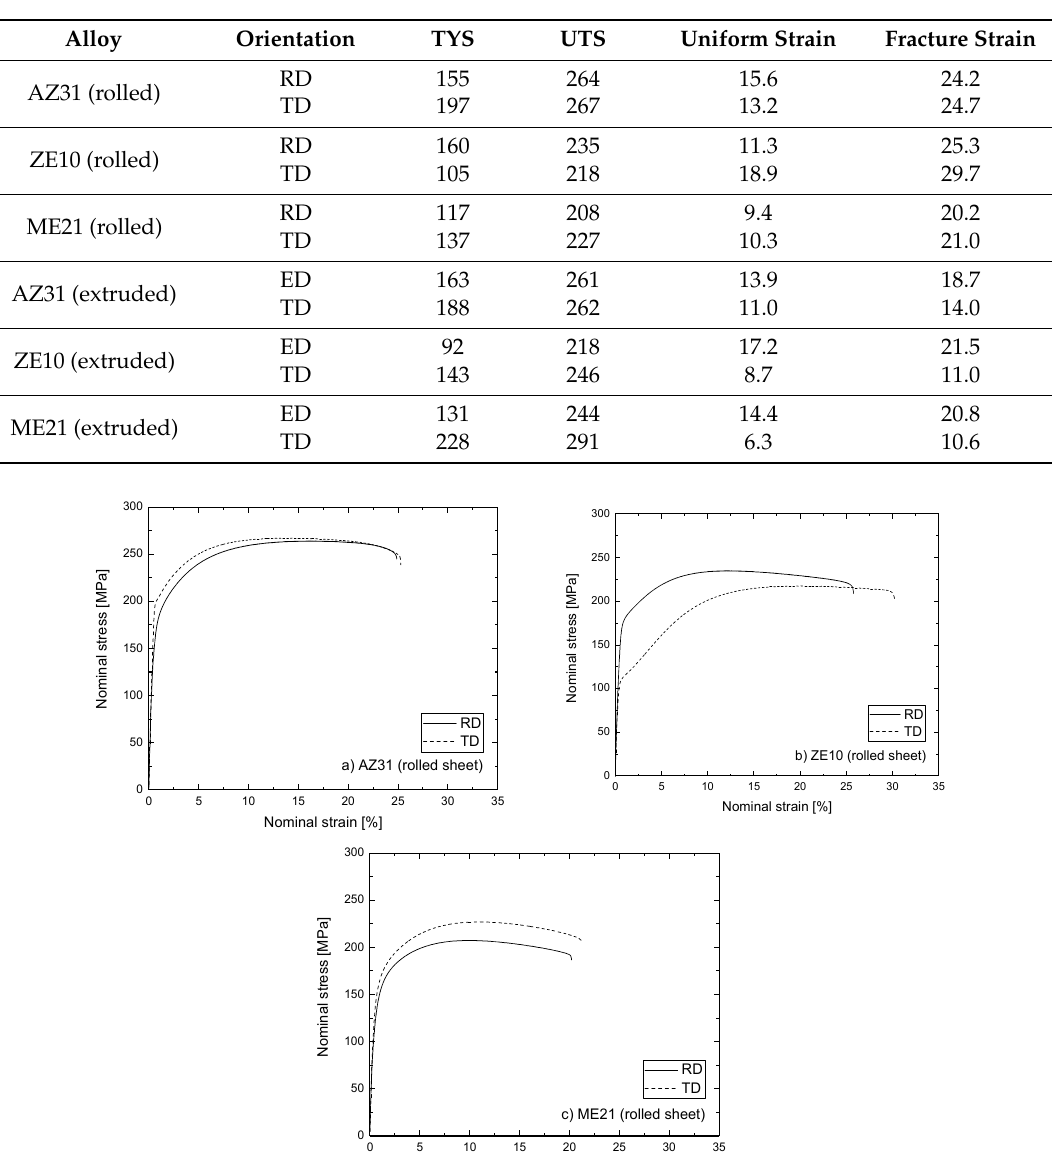
Table 2. Mechanical properties from tensile tests in the RD or the extrusion direction (ED), and the TD, at room temperature, of the rolled and extruded sheets (standard deviations: stresses cca. 2 MPa;